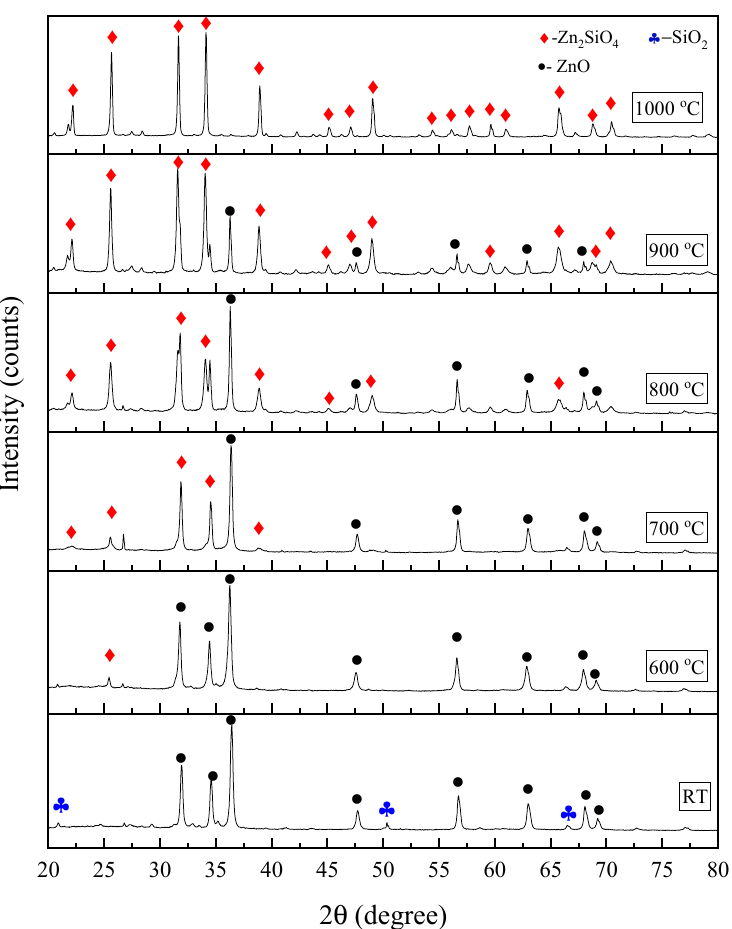
Figure 1. X-ray diffraction (XRD) spectrum of the ZnO-SiO 2 composite sintered at different temperatures. The FTIR spectrum of the ZnO-SiO 2 composite derived from coconut husk ash sintered at several temperatures was observed in the range of 400–4000 cm − 1 , as illustrated in Figure 2. The pre-sintering